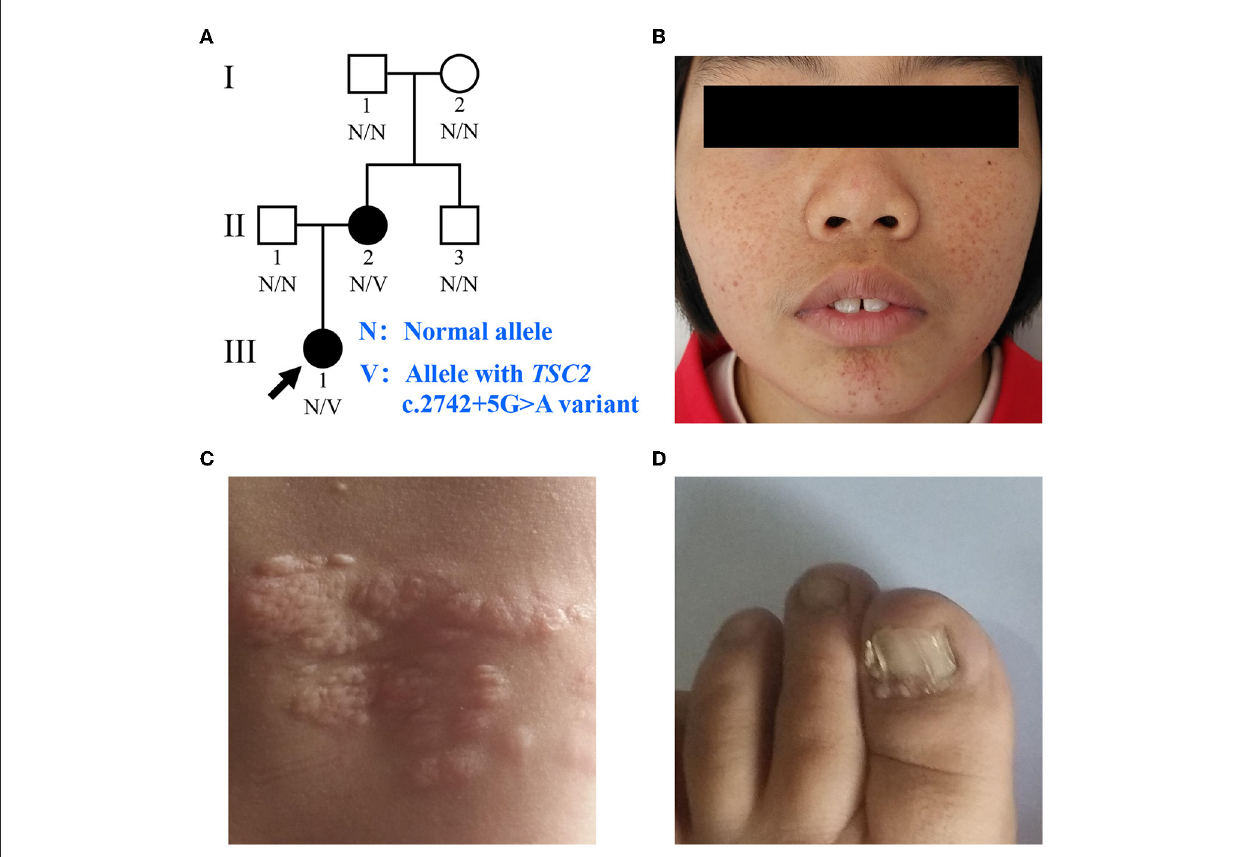
FIGURE1 Clinical manifestations of the family with TSC. (A) Pedigree of the family with TSC. N, normal allele; V, allele with the TSC2 c.2742 + 5G > A variant. The arrow indicates the proband. (B) Facial angiofibromas of the proband. (C) Shagreen patches of the proband. (D) Ungual fibromas of patient II:2.